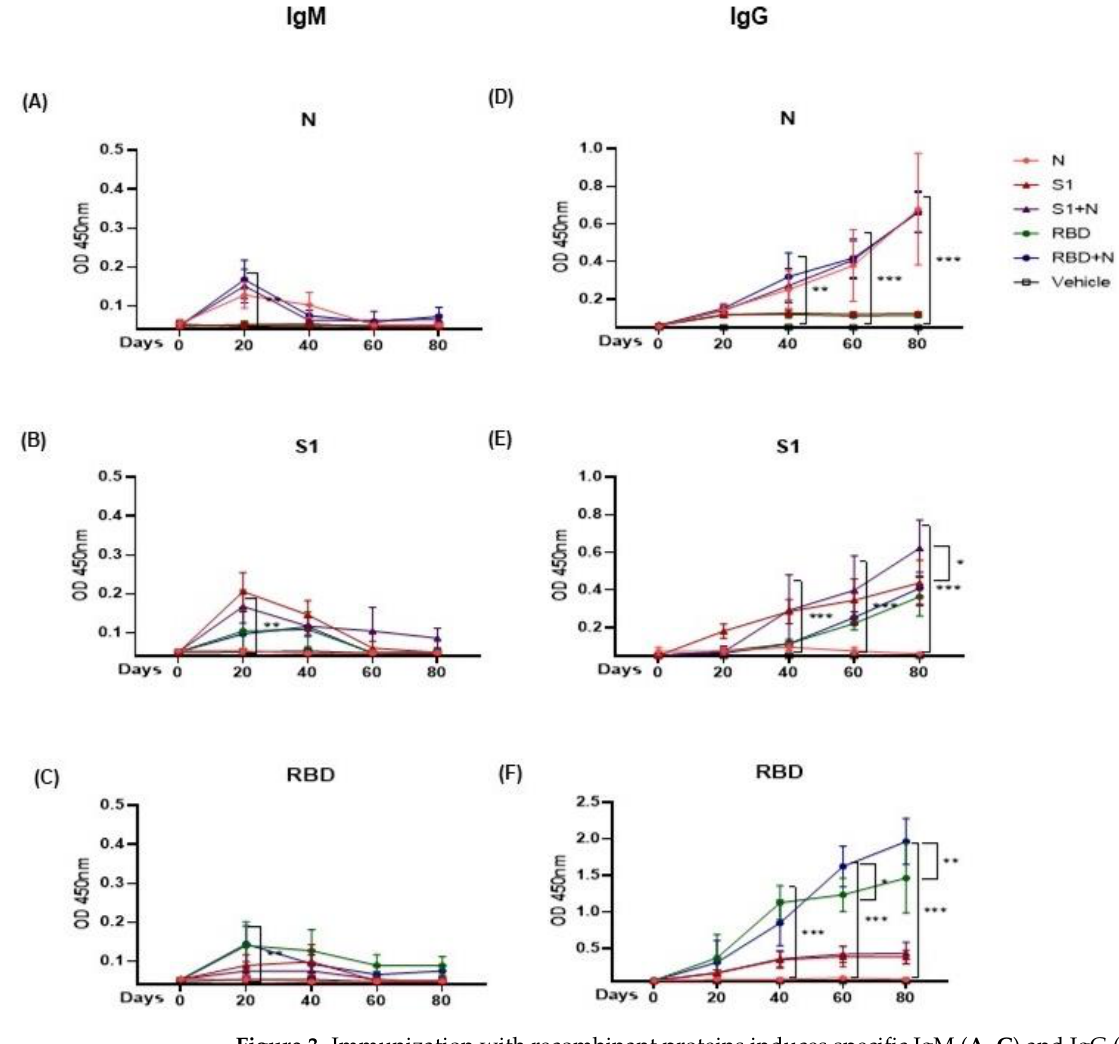
Figure 3. Immunization with recombinant proteins induces specific IgM ( A – C ) and IgG ( D – F ) anti- SARS-CoV-2 N, S1, and RBD antibodies, as evaluated using ELISAs. Sera were diluted to 1:200, and the results are expressed as O.D. at 450 nm, and the data of each group of 10 mice are plotted. For more than two samples, nonparametric ANOVA was used; bars represent the mean ± SD. * p < 0.05, ** p < 0.01, *** p < 0.001. p ≤ 0.05 was considered statistically significant. Prism v.8 software was used